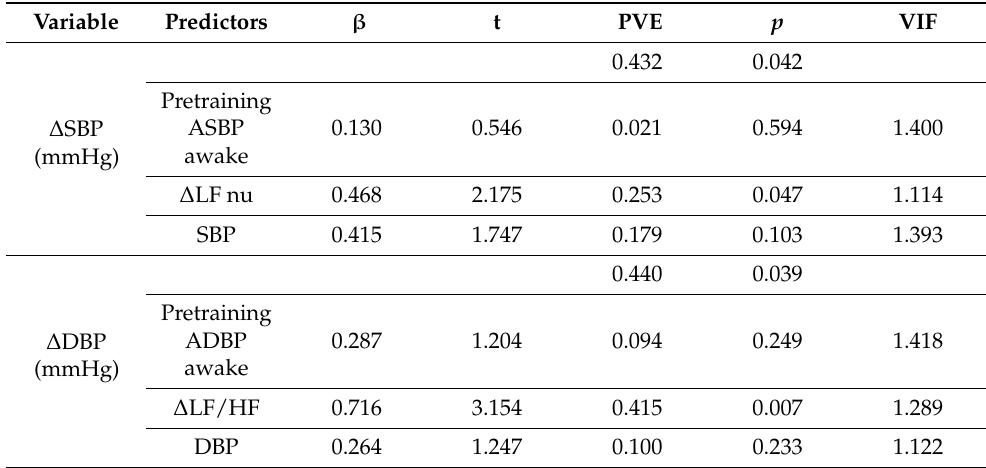
Table 6. Correlates of the blood pressure response to exercise